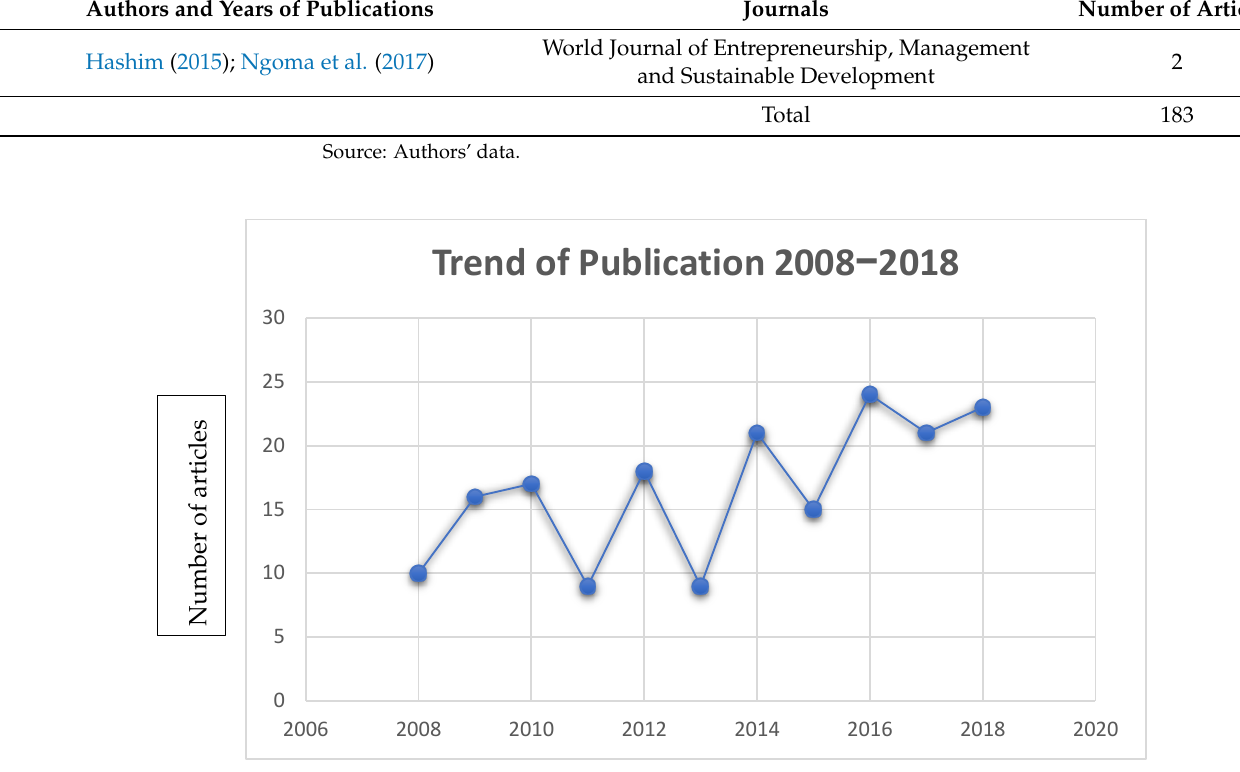
Figure 3. Trend of Publication. Source: Authors’ data